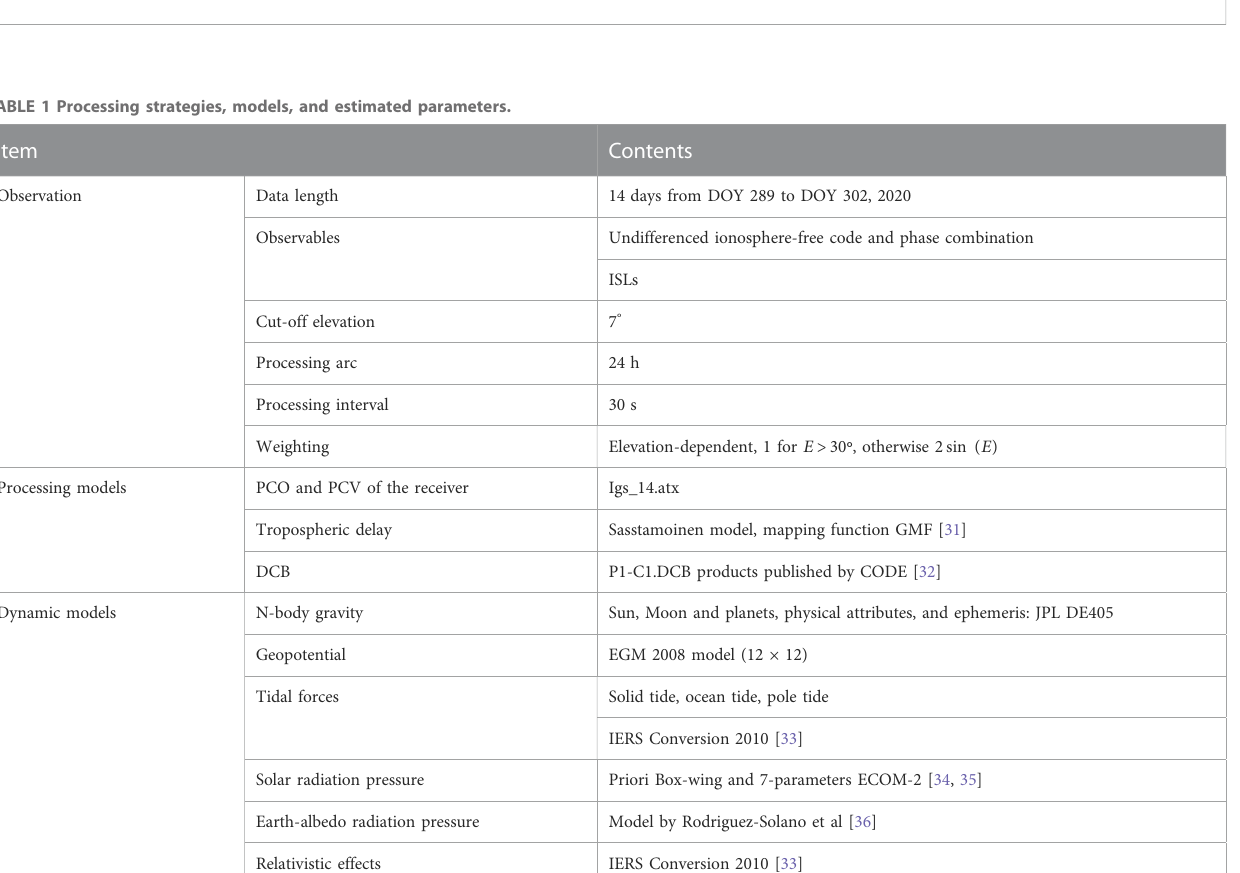
FIGURE 1 Distribution of 99 stations selected for calibration of PCOs and hardware delays for ISLs.